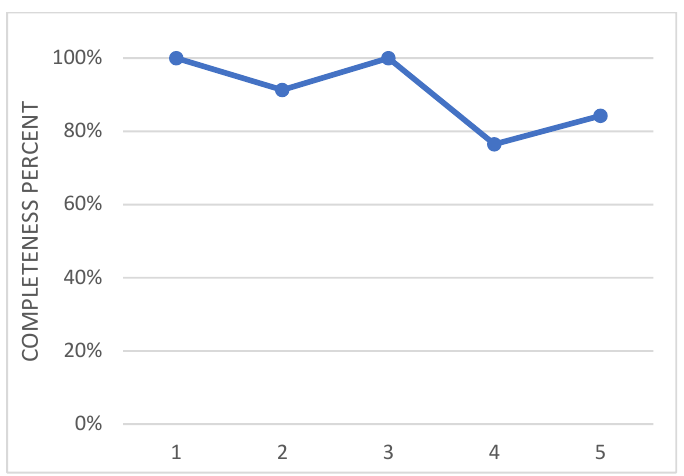
Figure 13. Overall level of maturity of the technology of the adaptive flap actuation system.